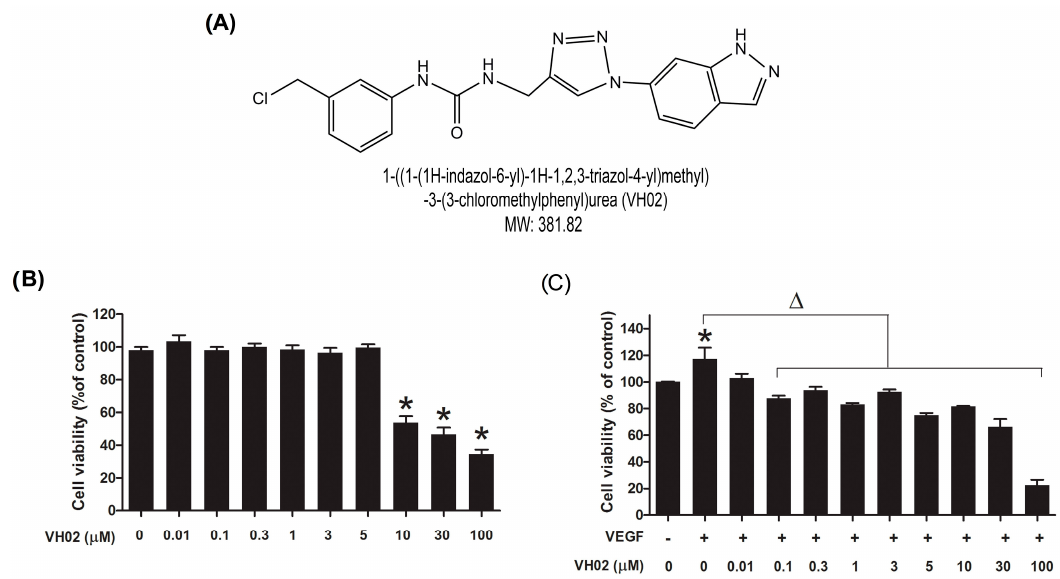
Figure 1. Effects of VH02 on EA.hy 926 cell viability. EA.hy 926 cells were treated with various concentrations of VH02 and co-incubated with or without VEGF (25 ng/mL) for 24 h. Cell viability was measured by MTT assay as described in the Materials and Methods section. ( A ) Chemical structure of VH02; ( B ) Cytotoxic effect of VH02 on the endothelial cells in the absence of VEGF (25 ng/mL); ( C ) Cytotoxic effect of VH02 in the endothelial cells in the presence of VEGF (25 ng/mL). * p < 0.05 compared with control (vehicle treated cells); Δ p < 0.05 compared with VEGF treated cells (VEGF control).